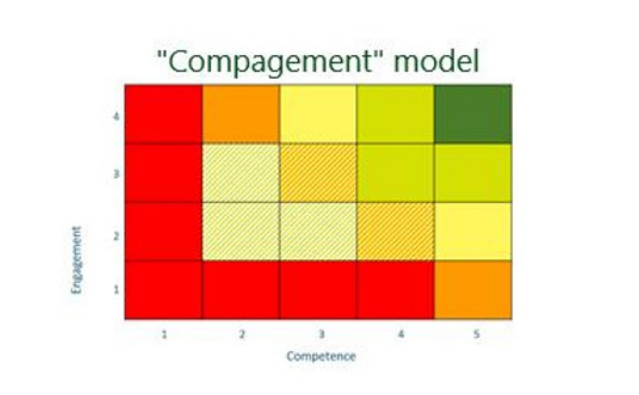
Fig. 5. «Compagement» model.